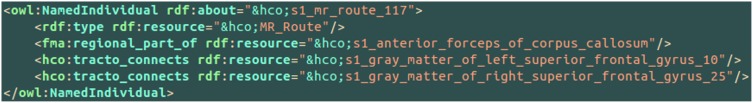
Illustration of the use of the hco:tracto_connects connectivity relationship between a fiber bundle assessed by diffusion tractography (i.e., hco:MR_Route) and different cortical parcels (i.e., hco:MR_Node) using terms of the Human Connectomics Ontology (HCO). The “fma” and “hco” prefixes denote entities of the Foundational Model of Anatomy (FMA) and of the HCO, respectively. The object property fma:regional_part_of denotes a part-whole relationship.